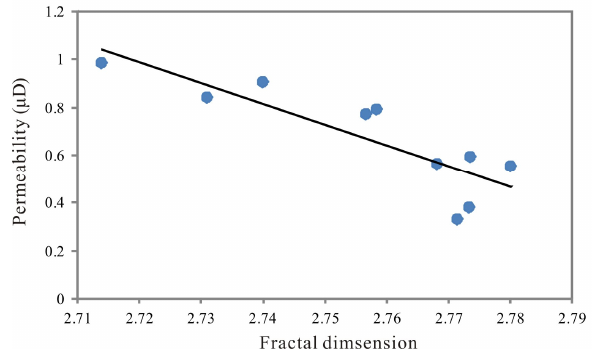
Figure 12. The relationship between fractal dimension and permeability.